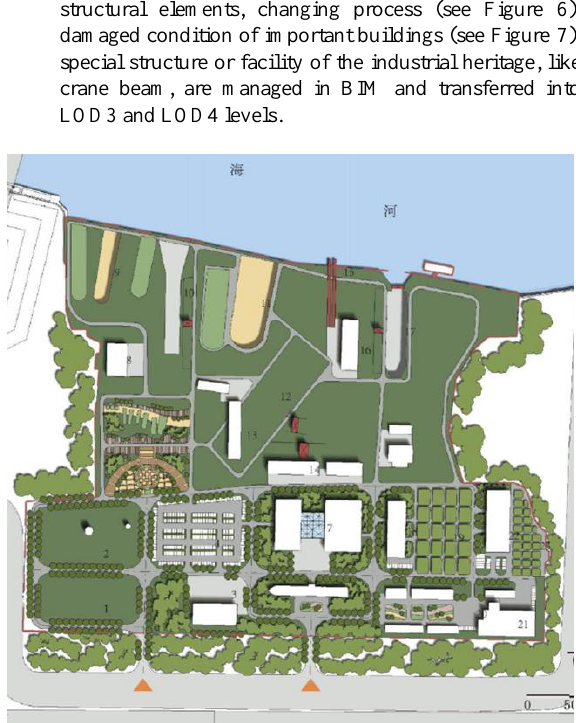
Figure 5 ． LOD1 heritage records of Dagu Dock of Beiyang